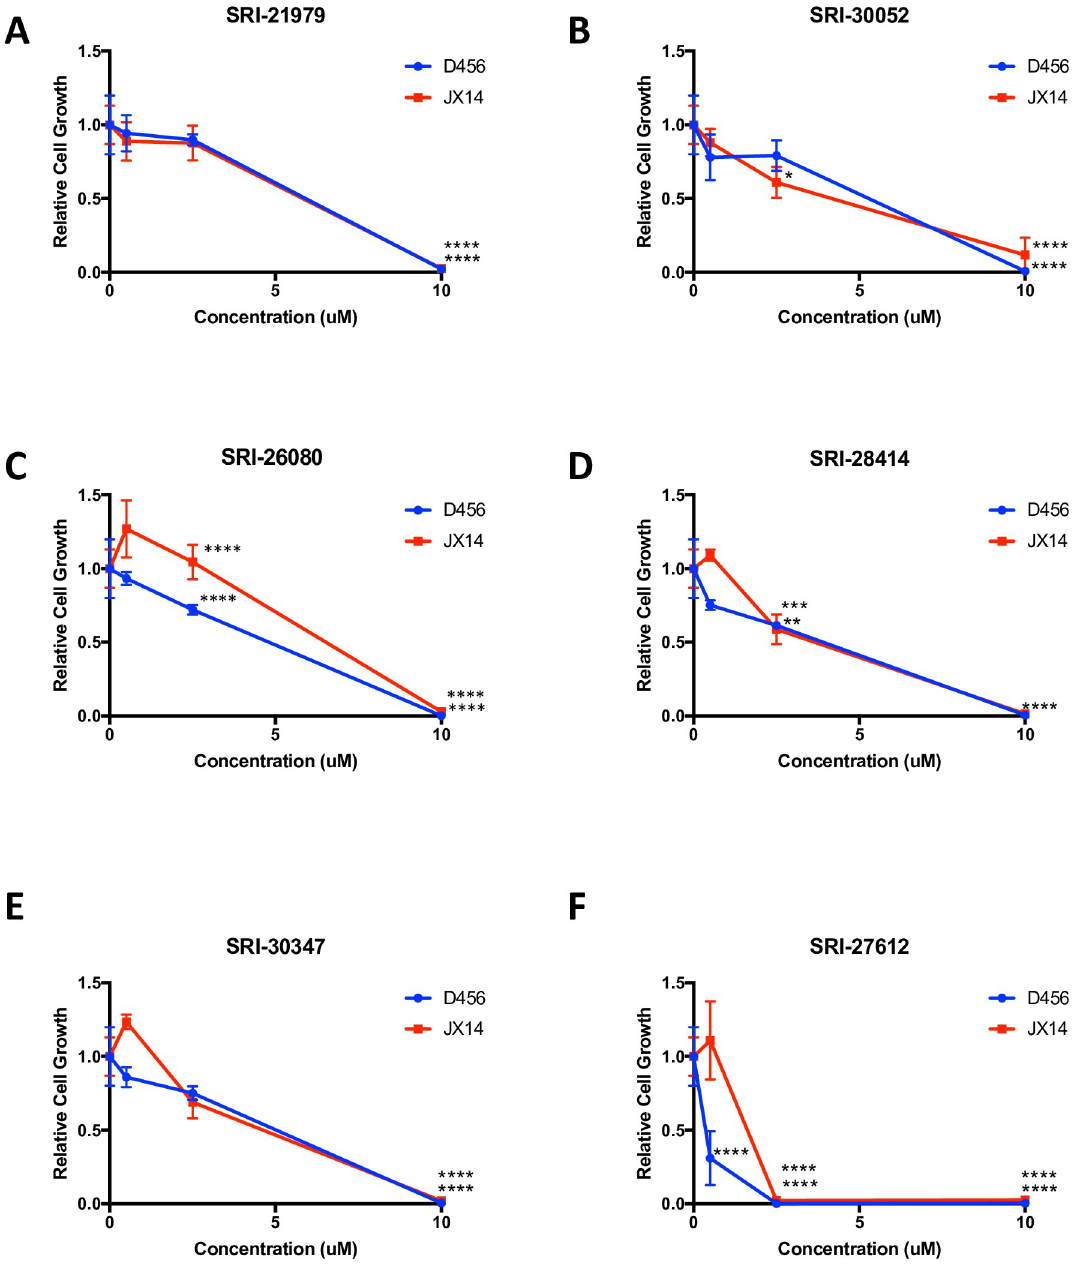
Fig 1. DRD3 antagonists significantly inhibit the growth of GBM PDX-derived neurospheres. Cells isolated from JX14 (red) or D456 (blue) GBM PDXs were treated with vehicle control or the indicated concentrations of (A) SRI-21979, (B) SRI-30052, (C) SRI- 26080, (D) SRI-28414, (E) SRI-30347, or (F) SRI-27612 and growth measured after seven days using Cell Titer assays. ���� p � 0.0001, ��� p < 0.001, �� p < 0.01, � p < 0.05 with ANOVA comparison to vehicle control. brains of mice at fifteen and sixty minutes after intraperitoneal injection (Fig 2F and 2G). However, levels of SRI-27612 and SRI-28414 in the brain were low and substantially less than that of SRI-21979 and SRI-30052. The brain-to-plasma ratio was highest for SRI-21979 fol- lowed by SRI-30052. Furthermore, the brain-to-plasma ratio for SRI-21979 and SRI-30052